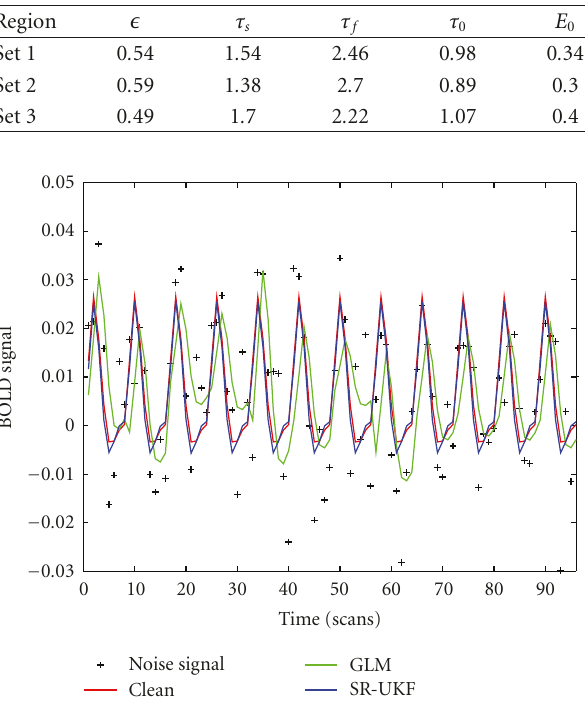
Figure 6: Comparison between the BOLD signal estimates obtained with the general linear model (GLM) and Balloon